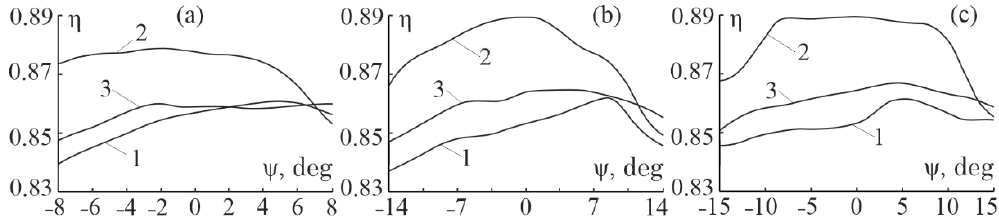
Figure 4. The calculated DE dependence on the angle of incidence for microstructures No. 3 of Table 2. At λ = 0.4 µ m (1); at λ = 0.55 µ m (2); At λ = 0.7 µ m (3). ( a – c ) correspond to P = 10, P = 20 and P = 30.